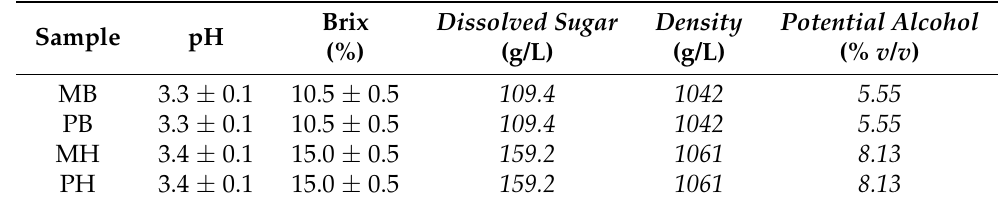
Table 6. Physico-chemical parameters of fresh must, control and plasma treated (MB-PB, MH- PH). Measured pH, Brix, as well as the estimated ( italic ) dissolved sugar and density by using VinoCalc [90], and potential alcohol by using Equation (1) (mean ± standard deviation).